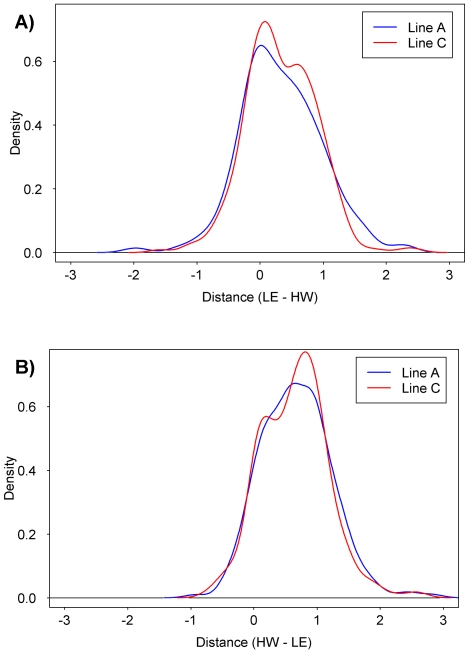
Heritability of mRNA Abundances.To analyze the heritability of mRNA abundances we used the two parental strains (L-E, H/W) and two lines resulting from L-E×H/W crosses (LnA, LnC). For each ProbeSet on the array we calculated where the Line-A and Line-C expression levels lie relative to the two parental strains. Values of zero indicate equivalent expression to the lower of the two parental strains, while values of one indicate equivalent expression to the higher of the two parental strains. A) Gaussian density plots of expression distances for Line-A and Line-C rats for ProbeSets where L-E expression is higher than H/W expression. B) Gaussian density plots of expression distances for Line-A and Line-C rats for ProbeSets where L-E expression is lower than H/W expression.